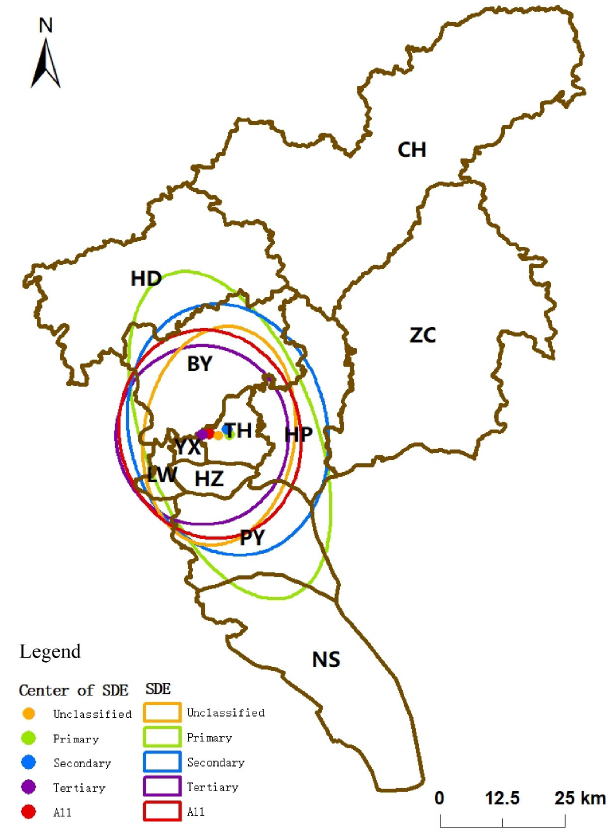
Figure 3. SDE spatial distribution of different levels of medical institutions.